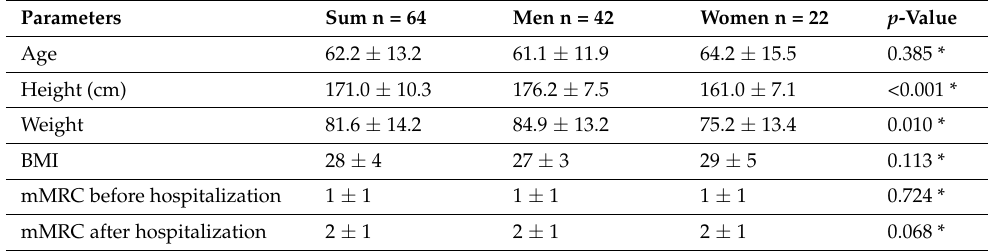
Table 1. Demographic and clinical data of the study’s population and their comparison according to sex.